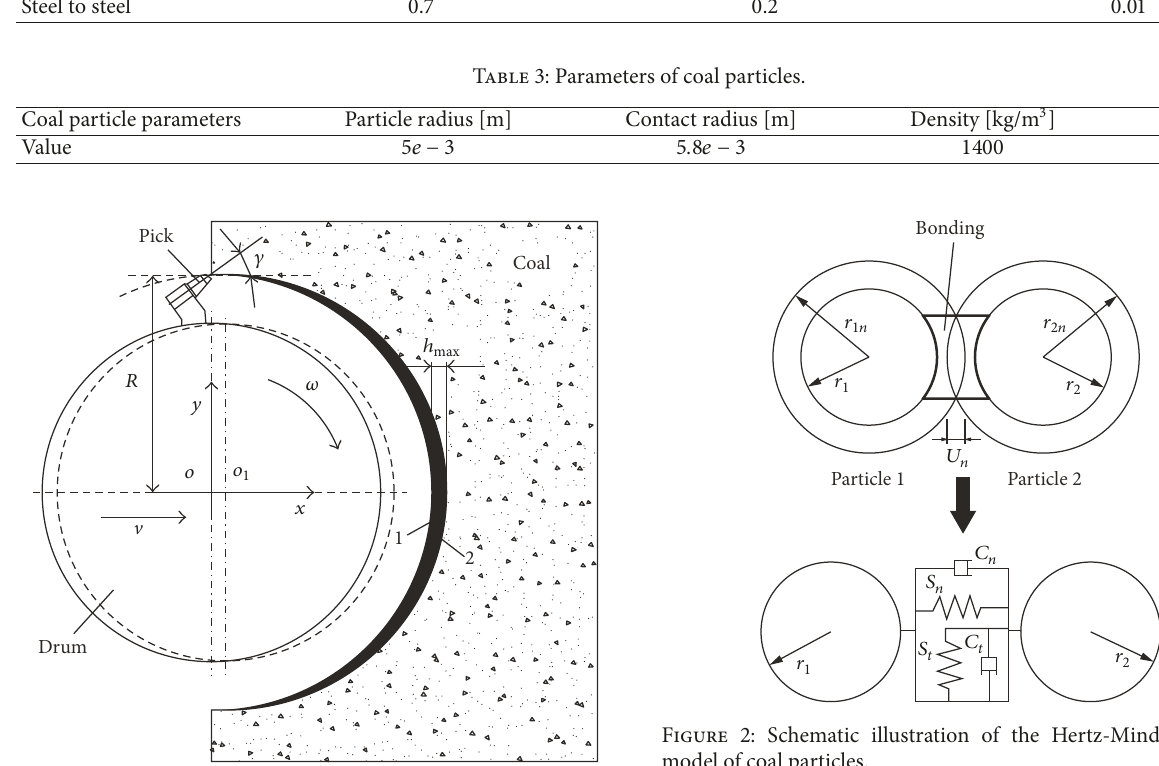
equal radius were simulated as coal particle in EDEM. The parameters of coal particles are shown in Table 3.